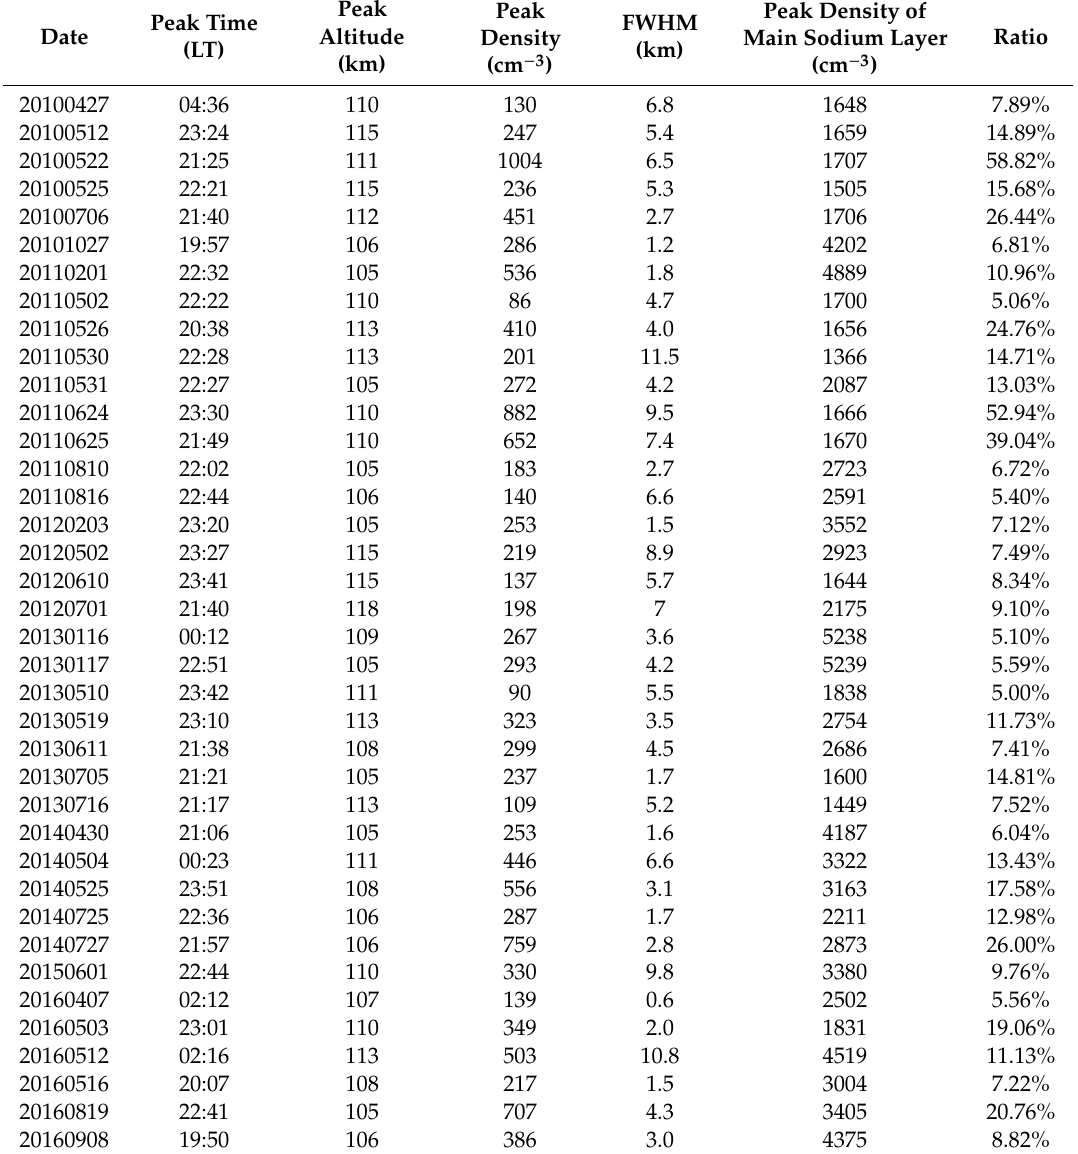
Table 1. List of the low thermospheric sodium layer (LTSL) cases during